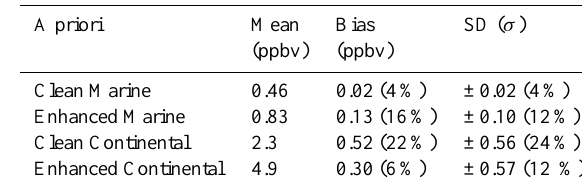
Table 3. Simulated retrieval results at level of maximum sensitivity (825hPa for continental and clean marine cases, 619hPa for en- hanced marine